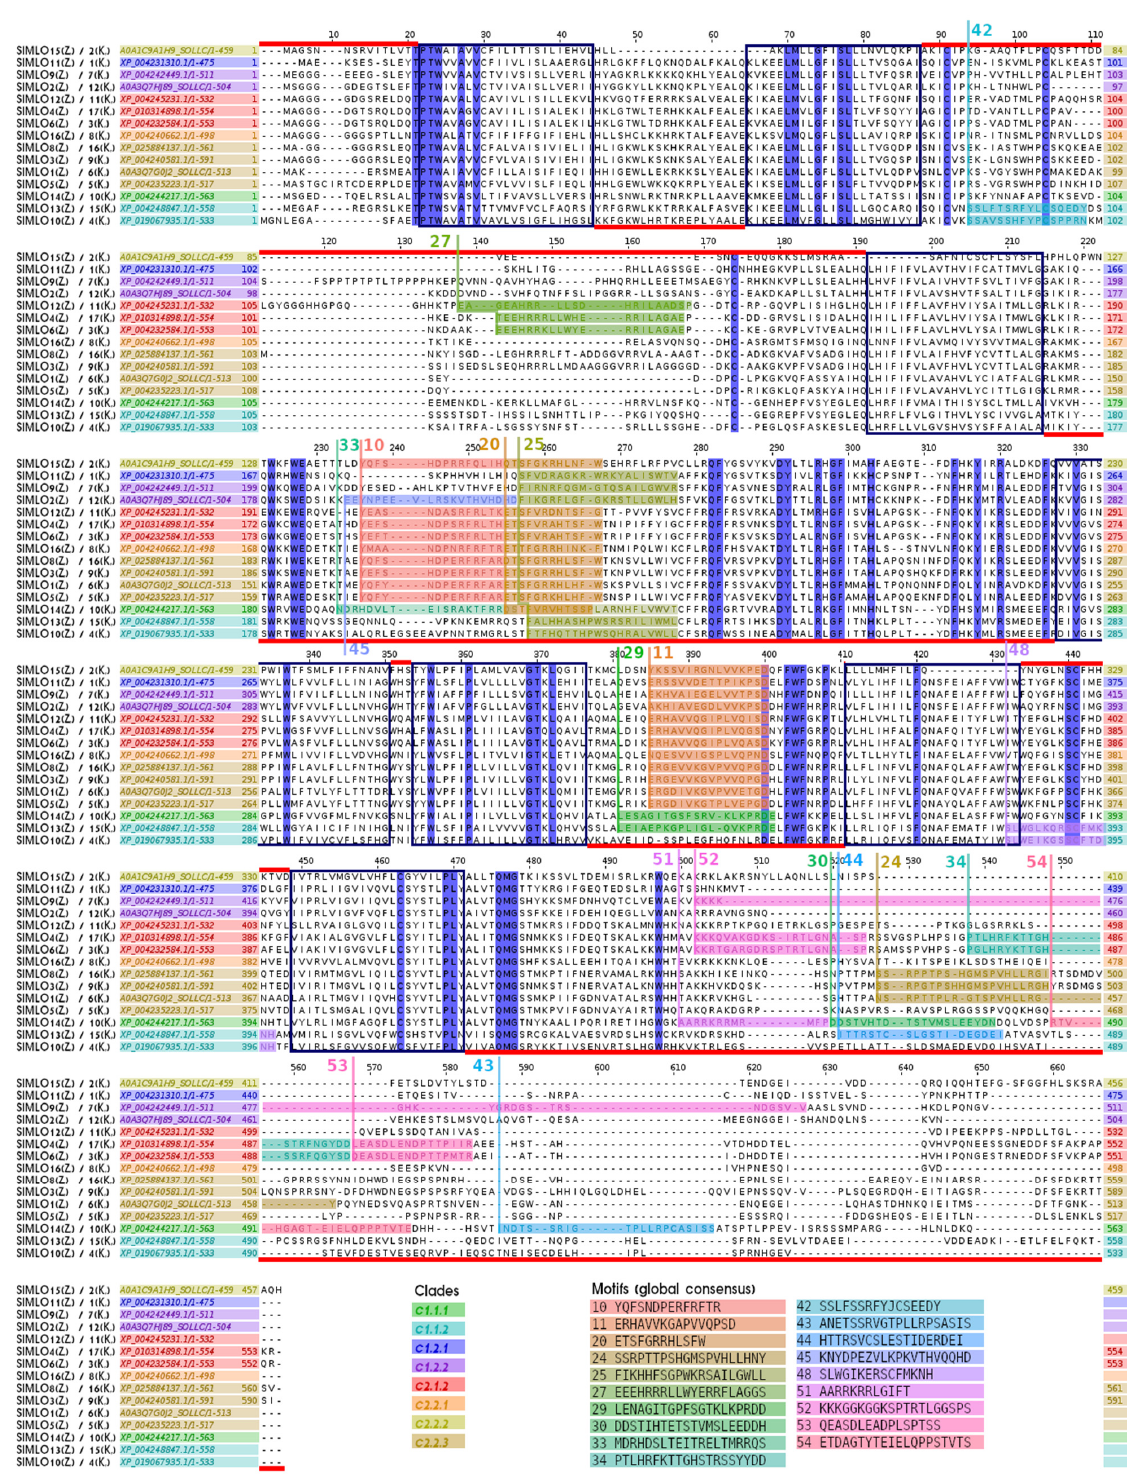
Figure 4. Multiple sequence alignment of the 15 MLO proteins from Solanum lycopersicum L. with the clade-specific motifs. The seven transmembrane domains are shown as boxes, according to Kusch et al. (2016). The red lines indicate the extracellular (above) or intracellular (below) localisation of the domain. The motifs shown in the alignment were enumerated in accordance with Table 3 and the corresponding sequences are listed below. The fully conserved positions are shown in blue. The SlMLO homologue names are listed on the left, according to Zheng et al. (2016) (Z.) and Kusch et al. (2016)